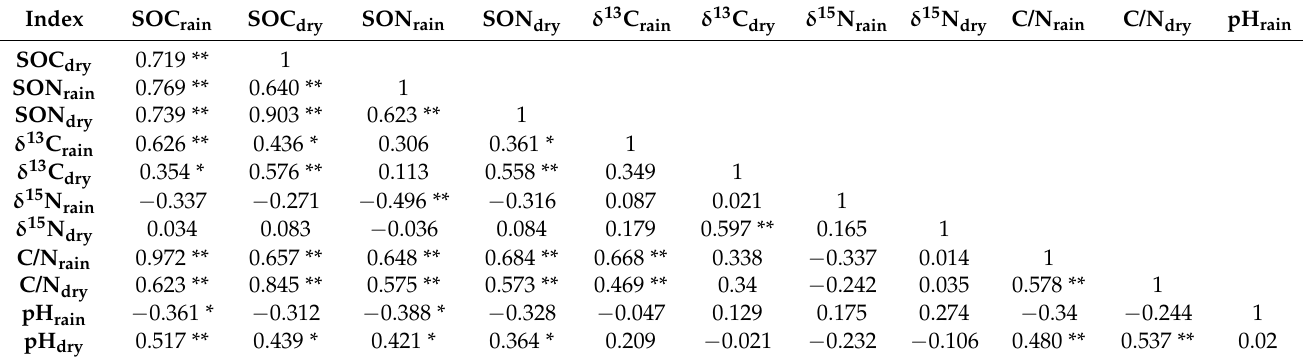
Table 2. Correlation analysis of the soil traits in the karst areas in the dry and rainy